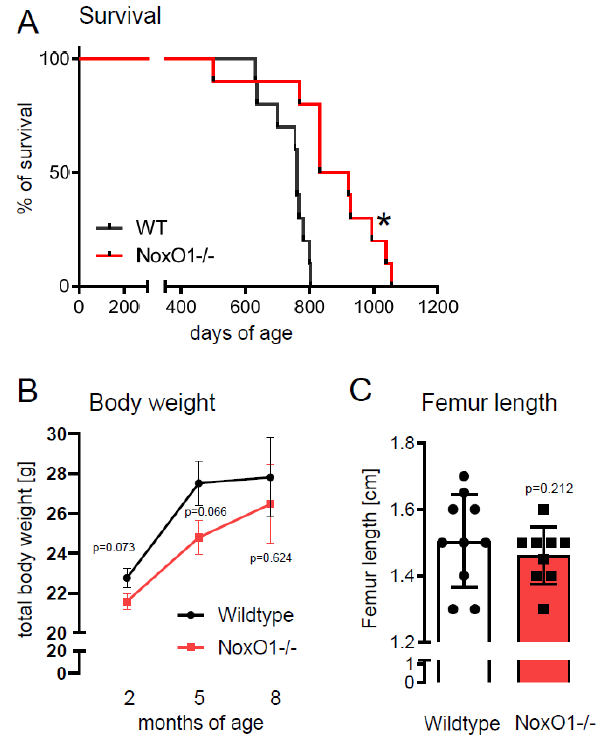
Figure 1. ( A ) Kaplan–Meyer curve for survival; ( B ) body weight development; and ( C ) femur length at the age of 12 weeks of male wildtype and NoxO1-/- mice. n = 9–10; * p < 0.05.